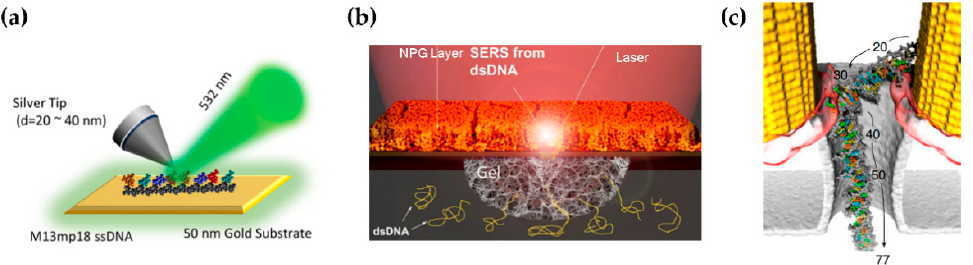
Figure 6. Biochemical sensing by SM-SERS. ( a ) Identification of single-stranded DNA by single- molecule TERS. Figure reproduced from [107]. The DNA molecules are deposited on the Au substrate. ( b ) The schematic of the plasmonic nanopore in the nanoporous film. NPG, nanoporous gold. Figure reproduced from [109]. ( c ) DNA sequence trapped in plasmonic nanopore. The base pairs are numbered in ascending order from tail to front of the molecule. Figure reproduced from [110].